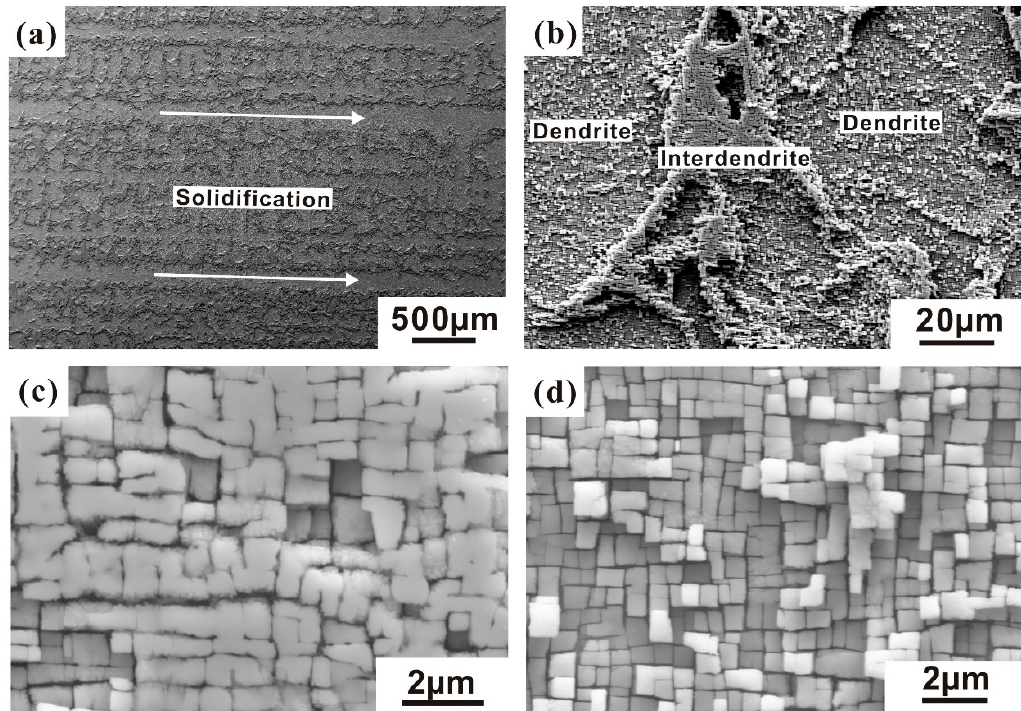
Figure 1. Secondary electron SEM micrographs of cast microstructures in single crystals (SX). ( a , b ) Dendrites and interdendritic regions; ( c ) microstructure in the interdendritic region; ( d ) microstructure in the dendrites.